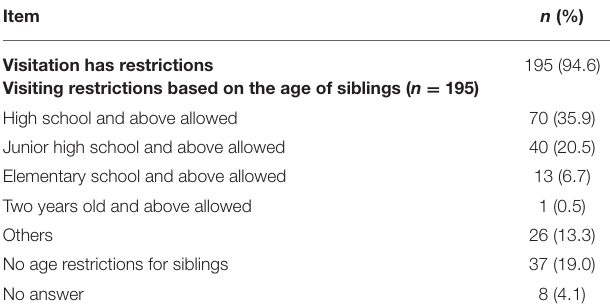
TABLE 4 | Bereavement support for siblings (multiple answers).